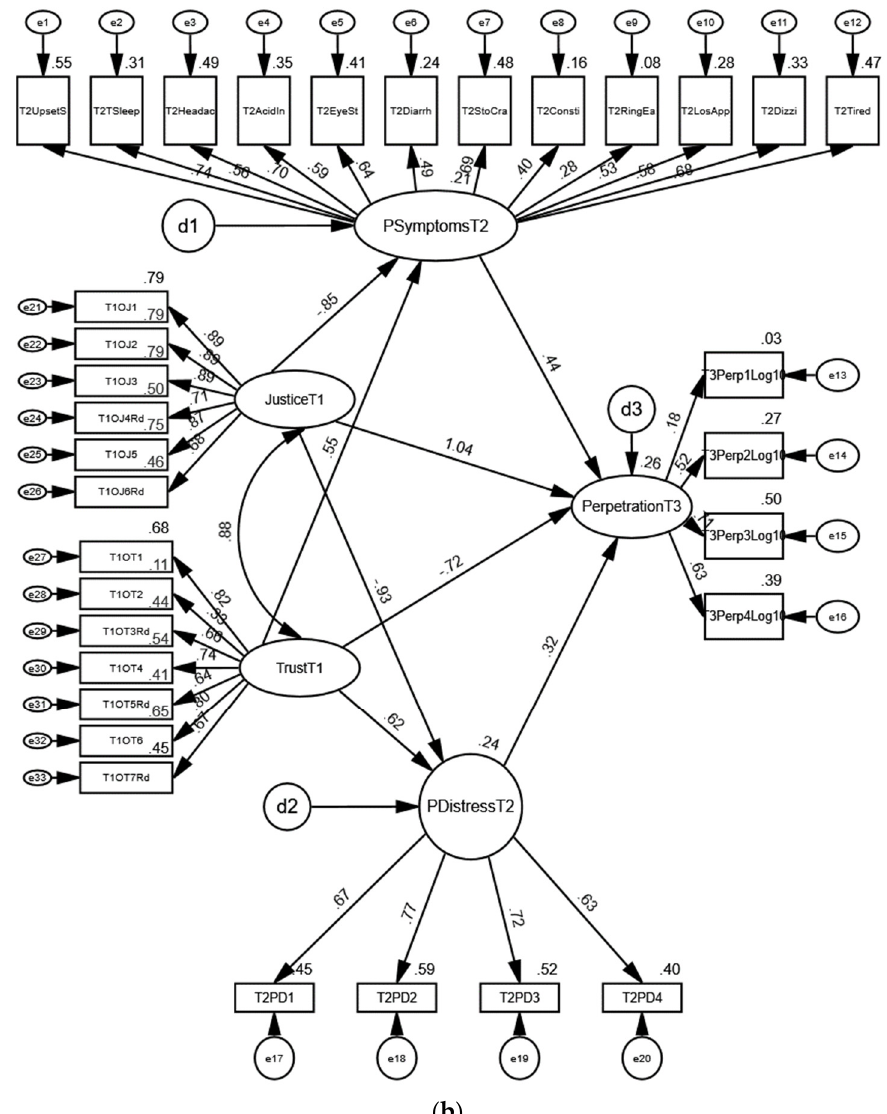
Figure 2. ( a ) Hypothetical structural equation model for mediation. ( b ) Structural equation model predicting perpetration (n = 2447).